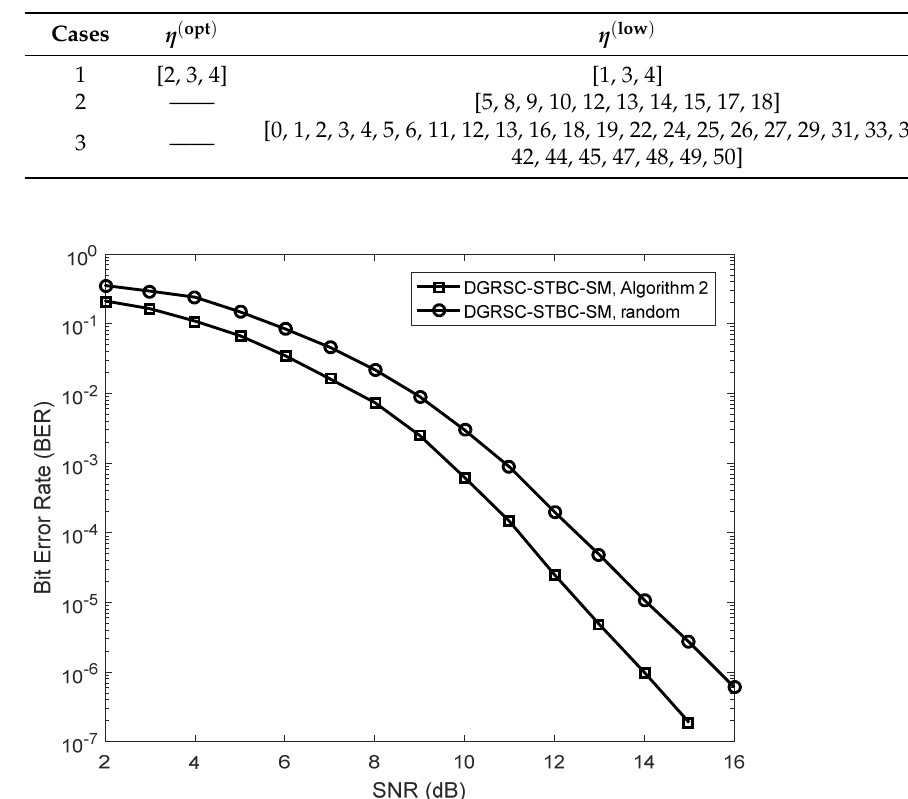
(25, 19, 7) and C (25, 10, 16) under S R = 3, N = 4 and 4 − QAM. t r